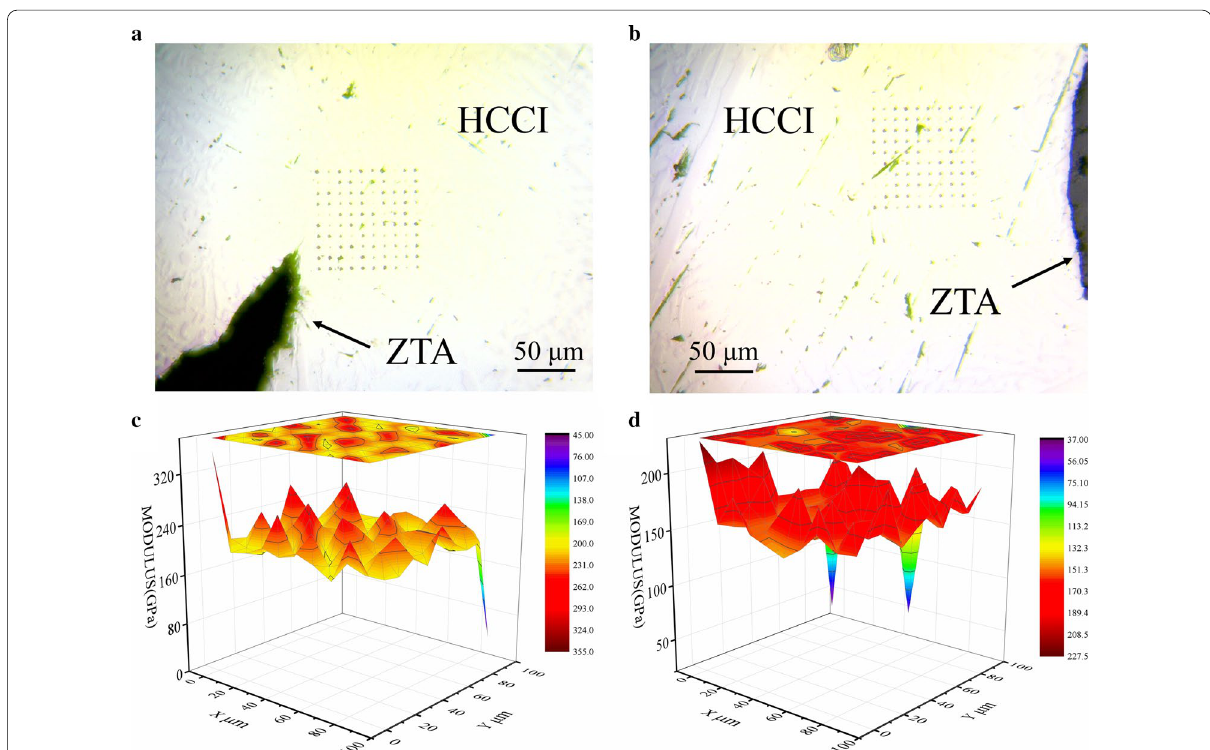
Fig. 10 Indentation distribution of composite materials and the distribution of Young’s modulus around the particles of composite materials. a The shape of the particles is sharp, b the shape of the particles is rounded, c the shape of the particles is sharp, d the shape of the particles is